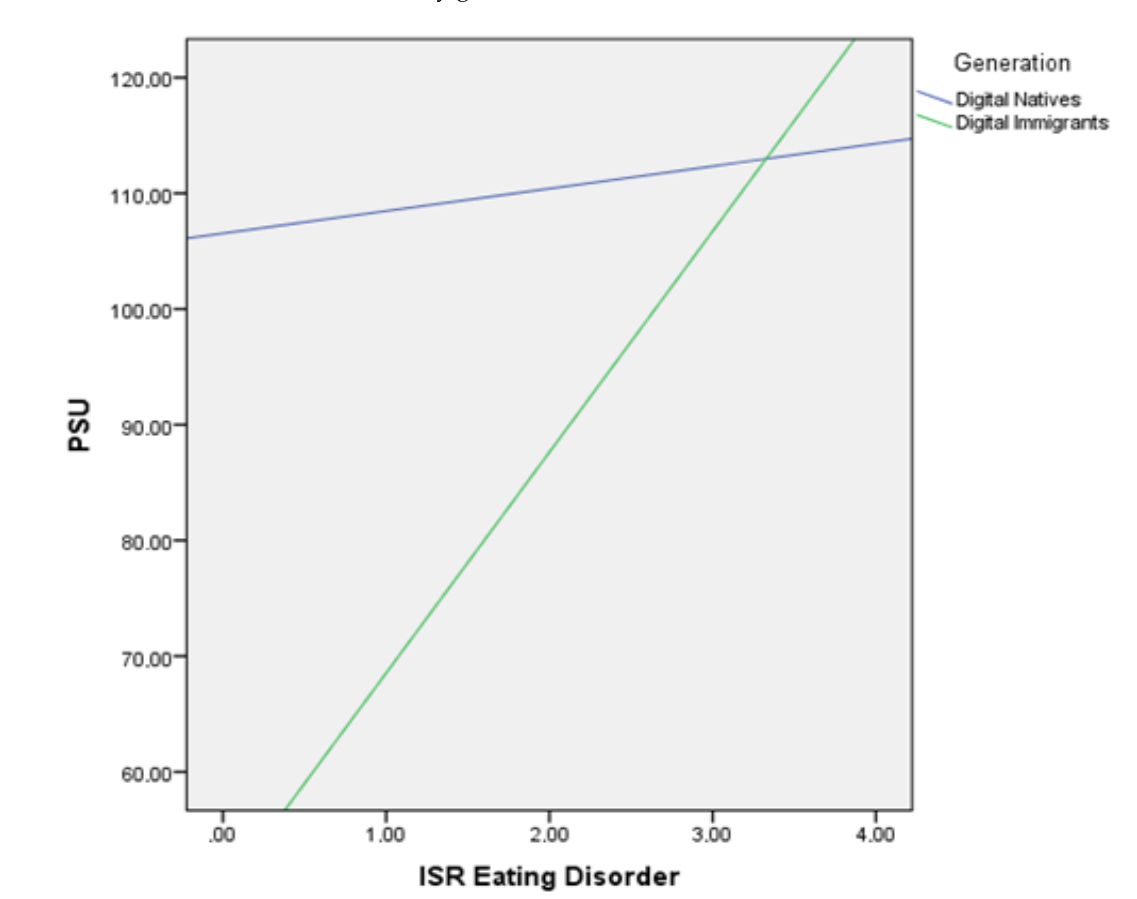
Figure 1. Interaction plot between eating disorder symptoms and PSU for digital natives and digi- tal immigrants.